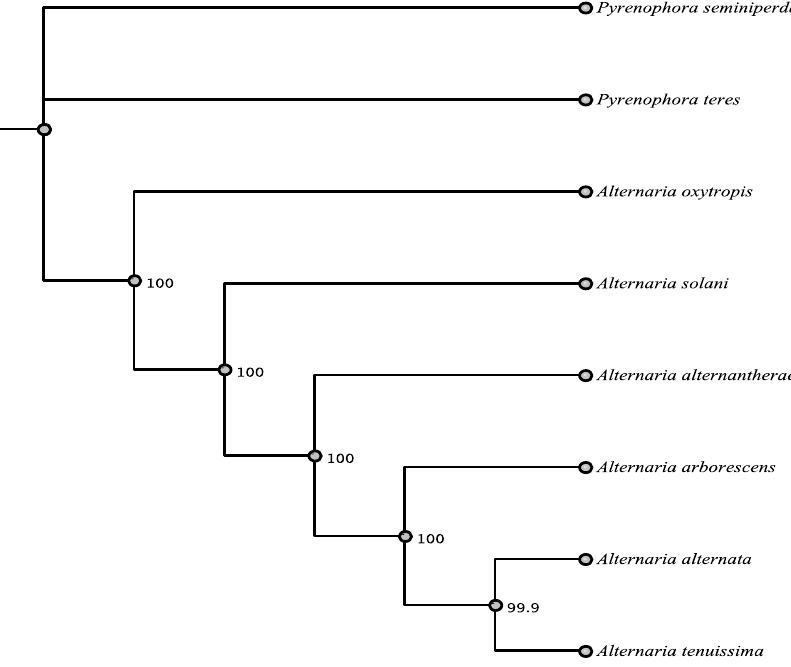
Figure 6. Maximum parsimony tree (MUSCLE alignment and 1000 replicates). Pyrenophora semini- perda was used as the outgroup. Fungi in tree are pblast results of 8407 sequence.